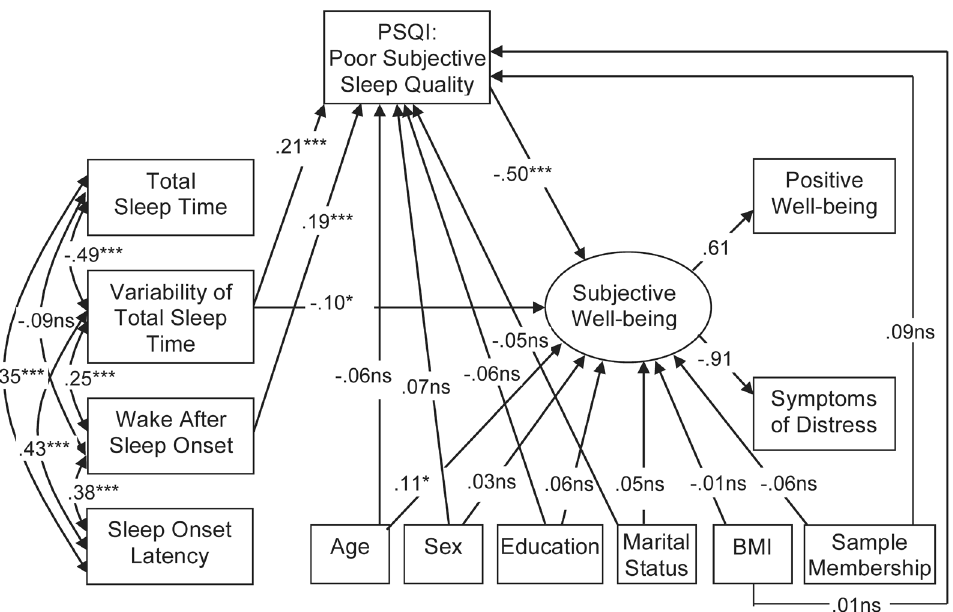
Figure 1. Relations of actigraphic sleep indices, subjective sleep quality, and subjective well-being. Standardized estimates are presented. Chi 2 = 32.9, df= 16, P= 0.008; CFI= 0.98 ; RMSEA= .049; GFI =0.99; AGFI =0.94. Note. Total Sleep Time, Variability of Total Sleep Time, Wake After Sleep Onset, and Sleep Onset Latency were assessed by actigraphy. Non-significant paths from actigraphy measures were trimmed, non- significant paths from covariates were not trimmed. Abbreviations: PSQI: Pittsburgh Sleep Quality Index; BMI: Body Mass Index. * P , .05, ** P , .01, *** P , .001, ns P . .05.